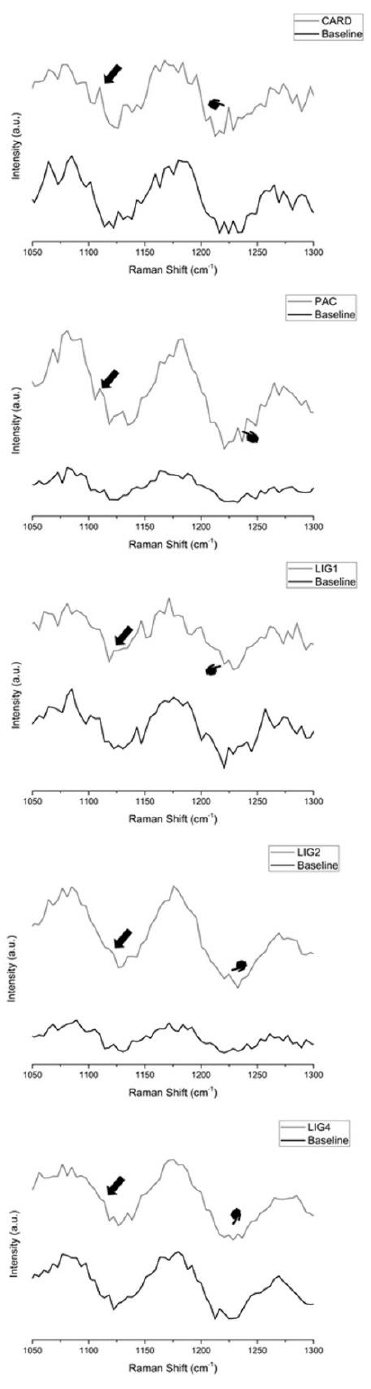
Figure 4. Vibrational Micro-Raman spectra of same specimens before (Baseline) and after 1 minute biomodification treatment. All agents induced emergence of shoulder at ~1117 cm −1 (black arrow) and increase of Amide III peak at 1235 cm −1 (pointers) which demonstrates collagen crosslinking. CARD: Cardadol; PAC: Proanthocyanidin; LIG: Lignin.